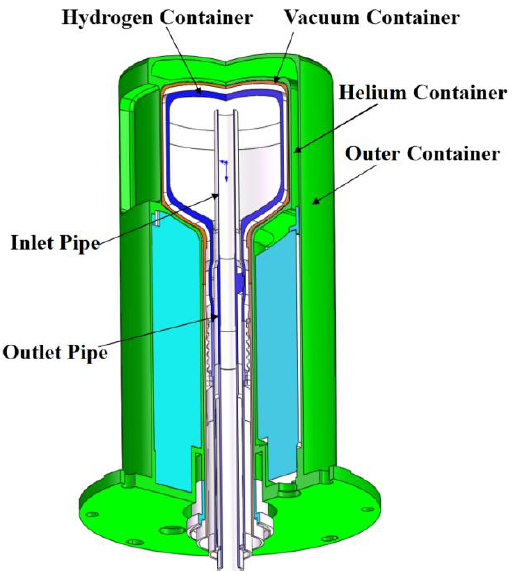
Figure 1. 3D View of coupled hydrogen moderator component in Chinese Spallation Neutron Source (CSNS).